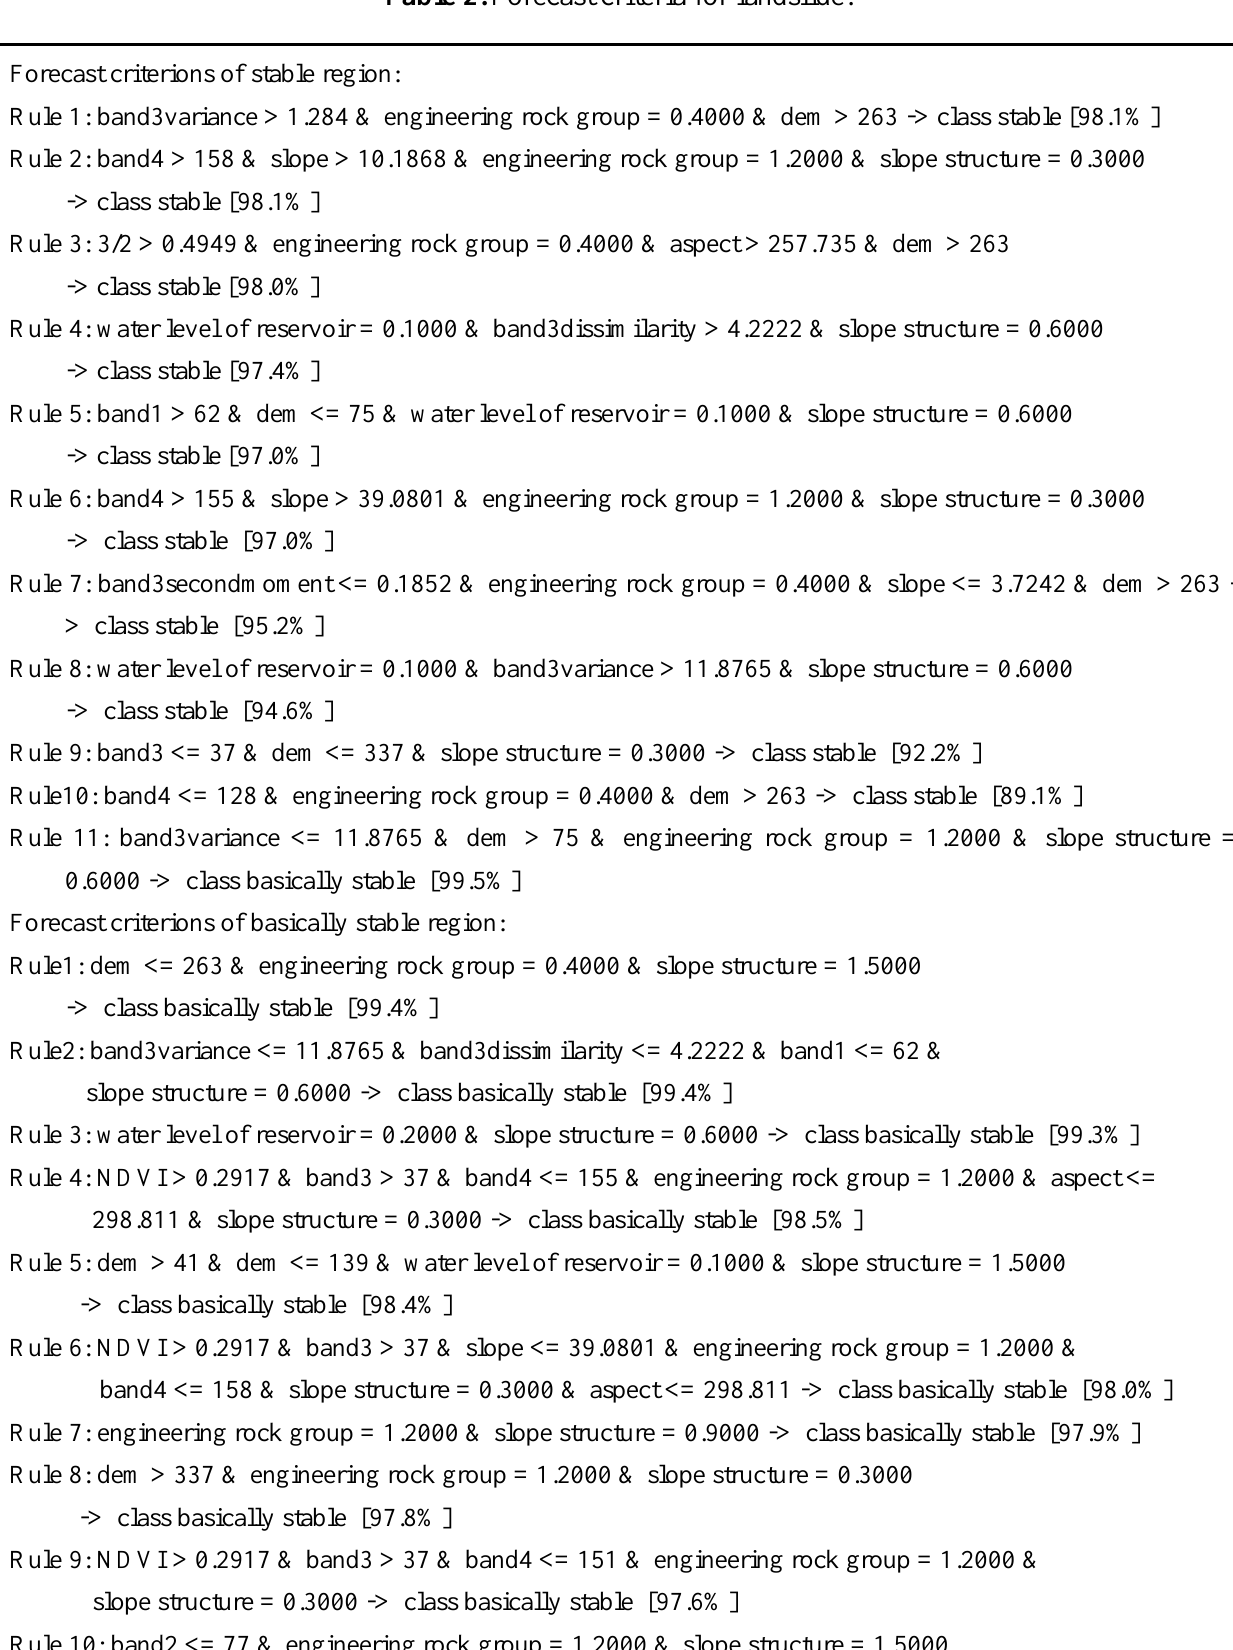
Table 2. Forecast criteria for